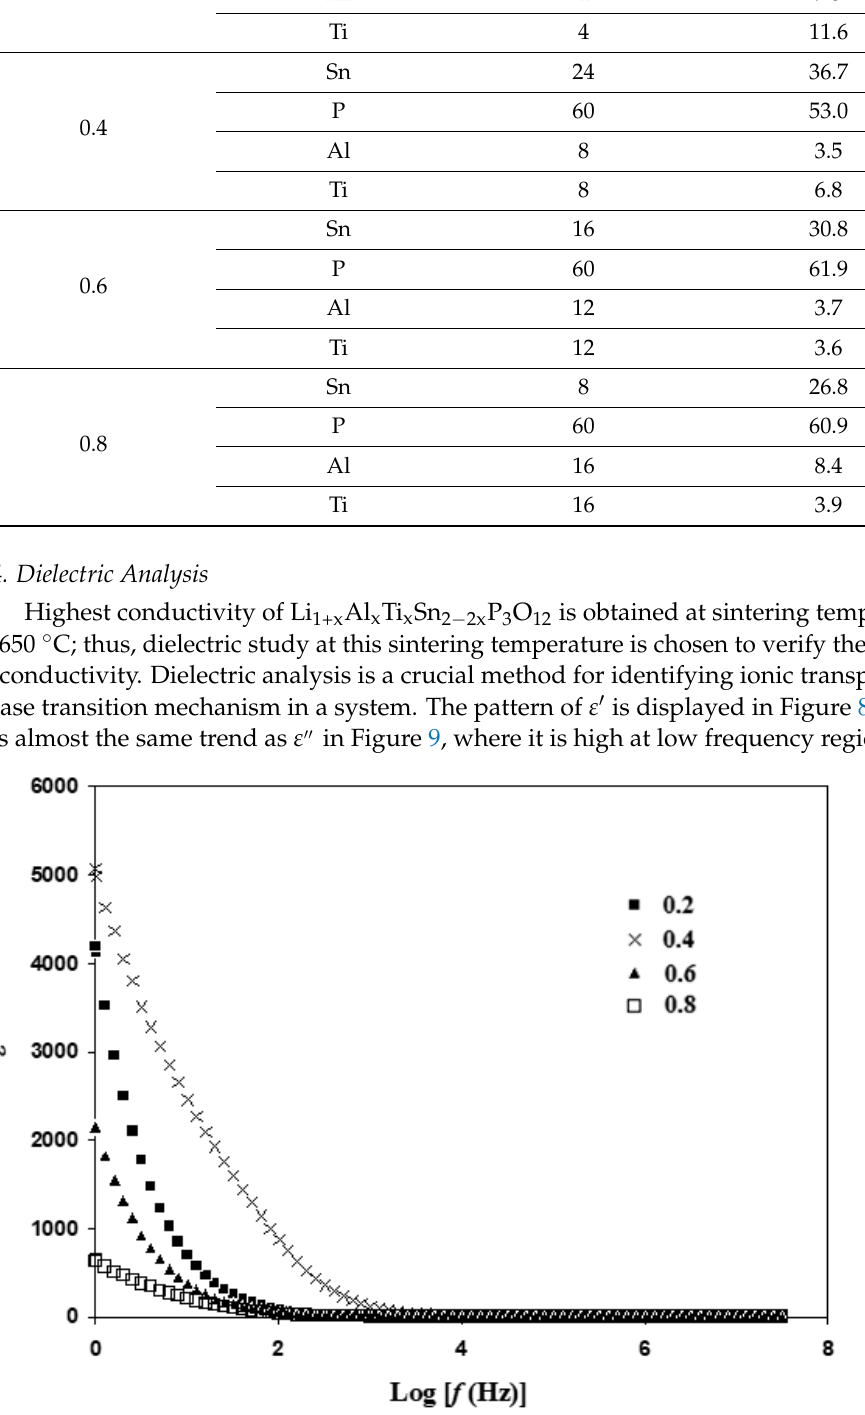
Table 3. Average value of atomic percentages of elements for all electrolytes at 650 °C.